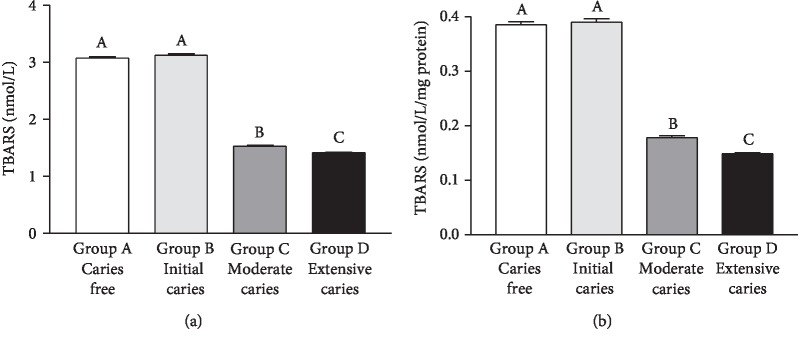
Concentration of 2-thiobarbituric acid-reactive substances (TBARS) (in nmol/L for the graph in (a) and in nmol/L/mg protein for the graph in (b)) in the saliva samples of caries-free children (Group A) and in those with caries at different stages (Groups B-D). Bars represent the mean ± SD. Equal letters represent statistical similarity (p > 0.05) and different letters mean statistical differences (p < 0.001).